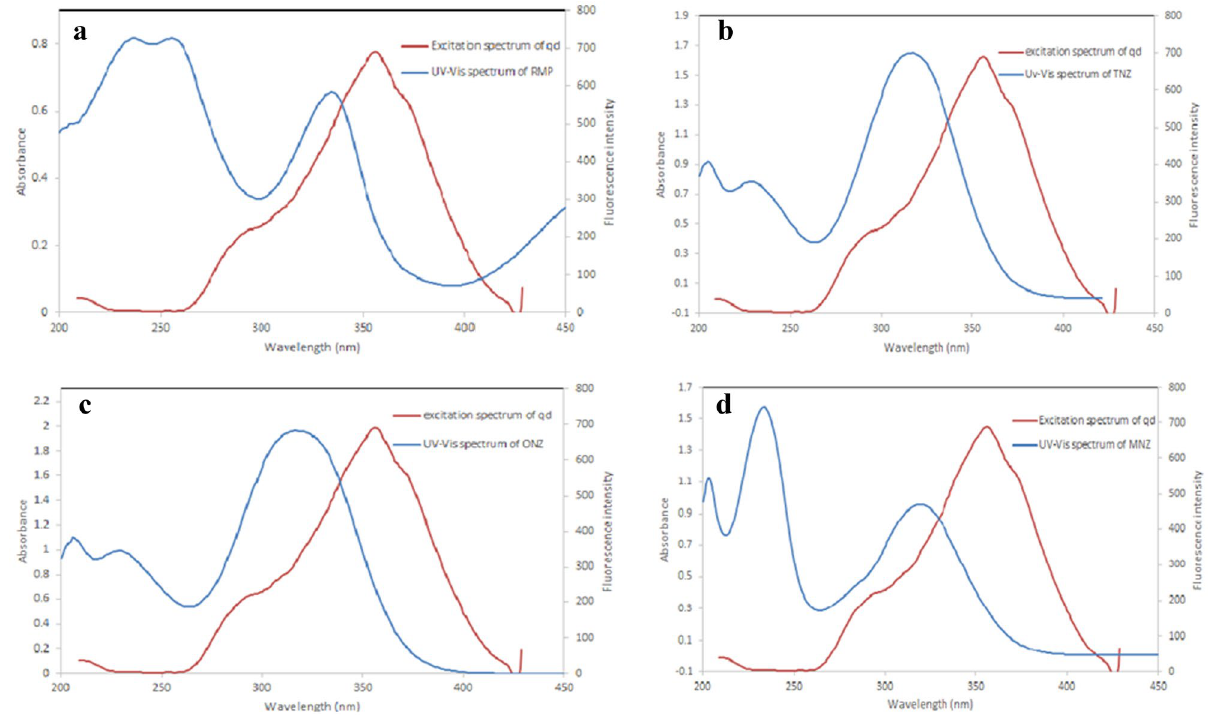
Figure 6. A Co-plot showing the overlap between UV–Vis absorption spectra of RFP ( a ), TNZ ( b ), ONZ ( c ), and MNZ ( d ) and the fluorescence excitation spectrum of the SN-CQDs.